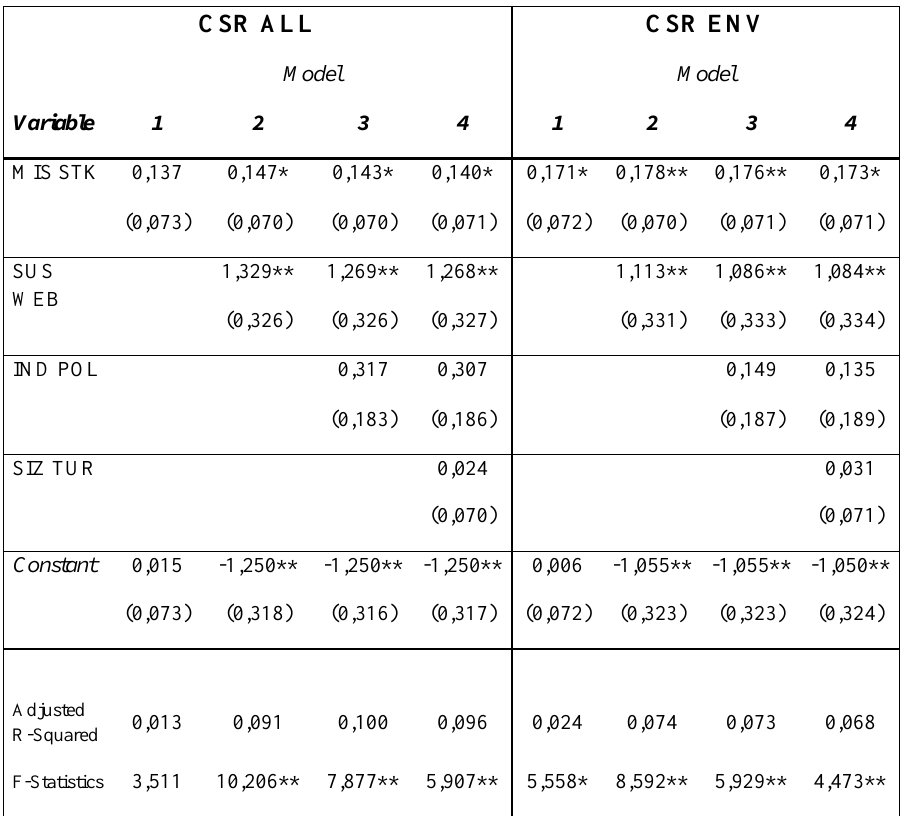
Table 3: Regression Analysis Results CSR ALL CSR